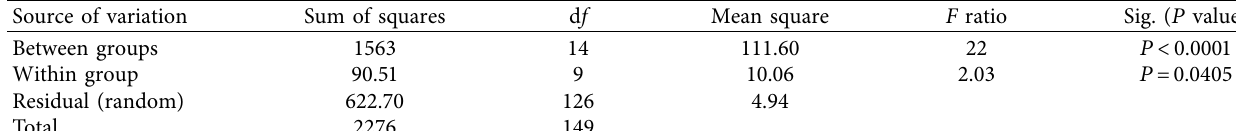
Table 4: Results of